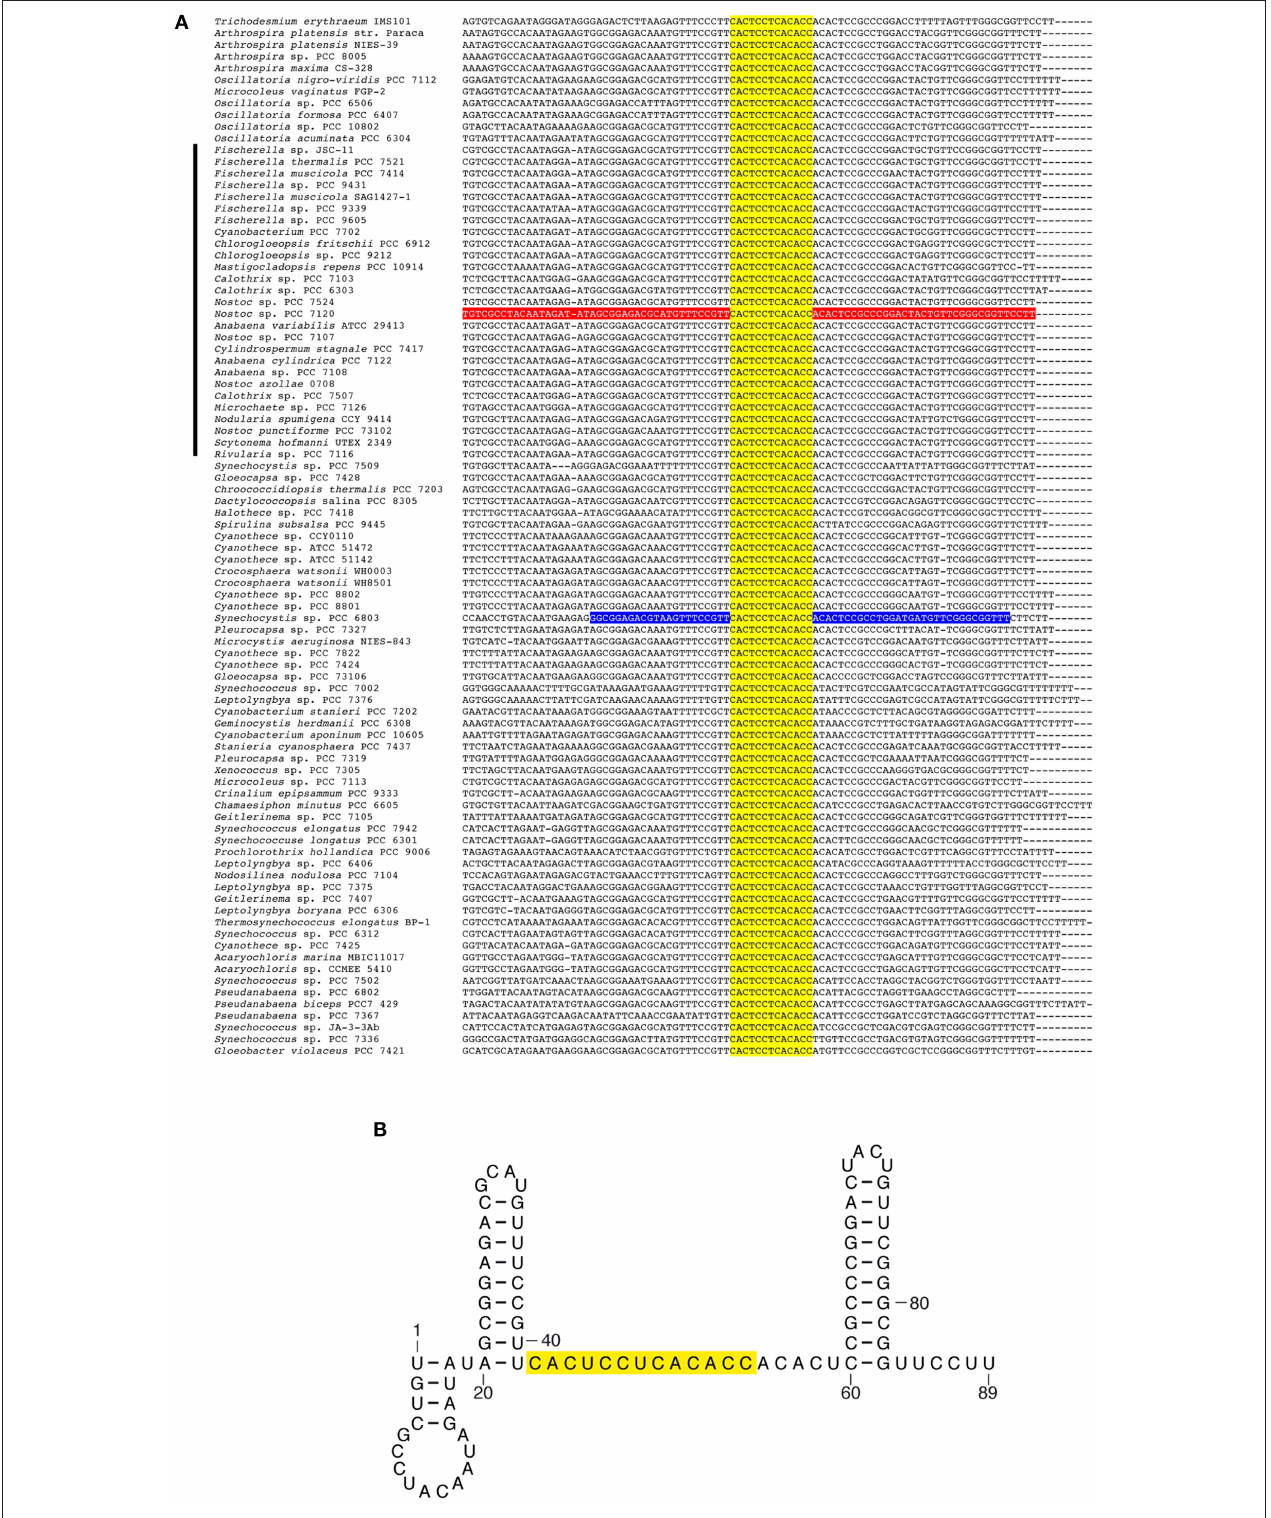
FIGURE 3 | Alignment of Yfr1 homologs and predicted secondary structure of Yfr1 from Nostoc sp. PCC 7120. (A) Alignment of sequences encoding Yfr1 homologs in 89 cyanobacterial genomes. The predicted transcript in Nostoc sp. PCC 7120 is shown in red. The described Yfr1 for Synechocystis sp. PCC 6803 (Mitschke et al., 2011a) is shown in blue. Genomes of heterocystous cyanobacteria are indicated with a black bar on the left side. (B) Predicted secondary structure of Yfr1 from Nostoc sp. PCC 7120. The sequence of a fully conserved motif is shown in yellow.